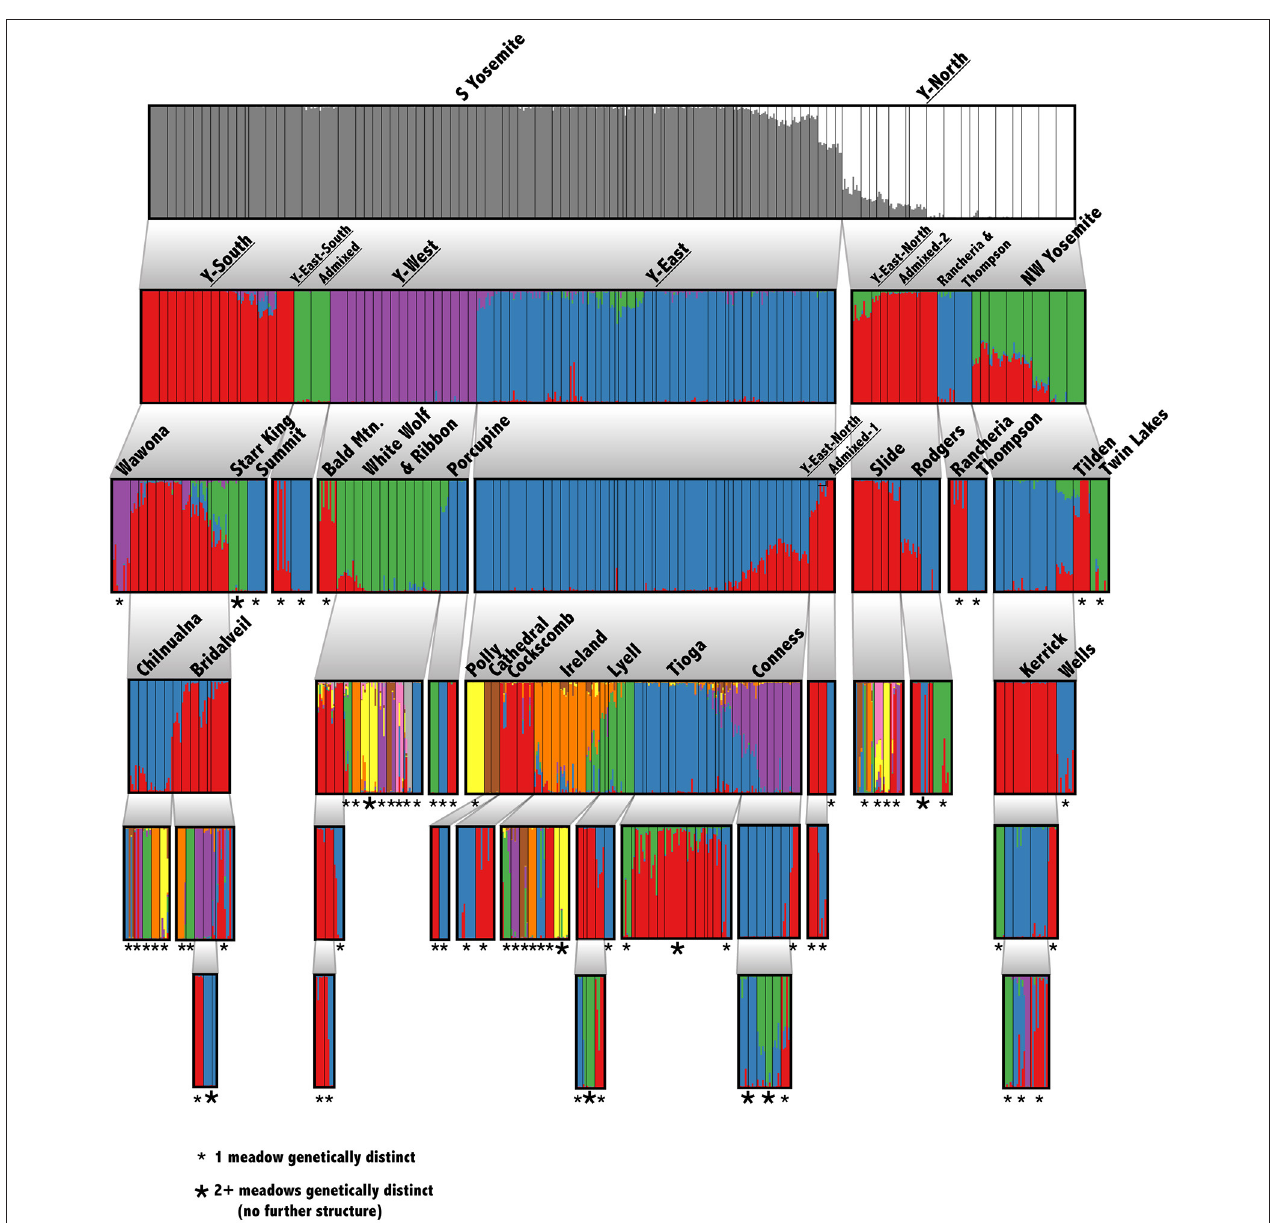
FIGURE 2 | Hierarchical genetic structure in Yosemite NP. Barplots of recursive STRUCTURE analyses down to the smallest detectable unit. Thin, black, vertical bars indicate meadow boundaries. Each analysis considered a range of K from 1 to 10, and the optimal K was chosen following Evanno et al. (2005). The hypothesis that K = 1 was tested using a paired Wilcoxon test. Each cluster was rerun until reaching the meadow level or finding no further structure. The smallest detectable unit is labeled: single meadow (small *) or multiple meadows (large *). Phylogenetic lineages from Maier et al. (2019) are underlined.